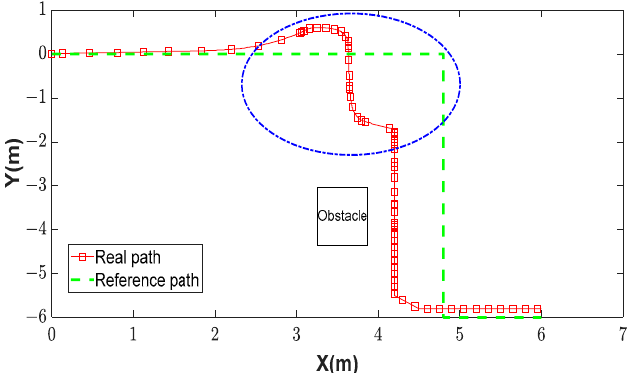
Figure 13. The real path of the wheelchair movement and the reference path.